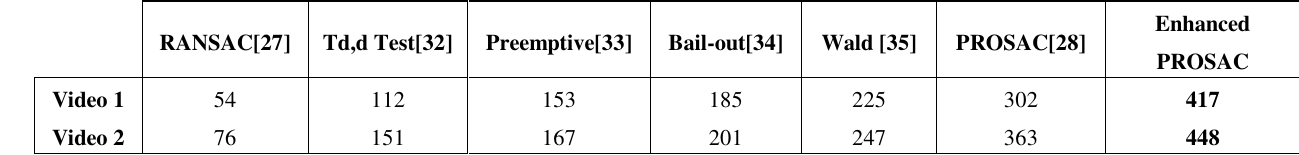
Table 2. Comparison of successful relocalisation